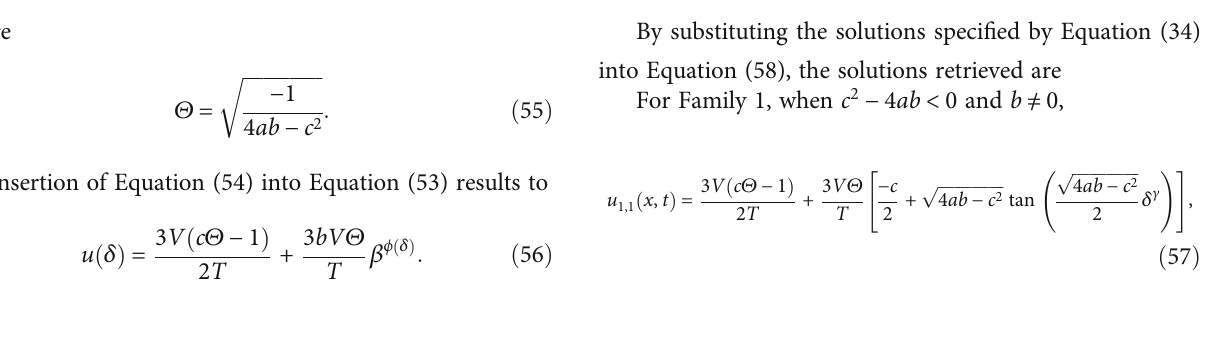
= 1 , T = 2 , V = 1 , c = 3 , a = 1 , b = 1 , and γ = 0 : 5,0 : 7,0 : 9 for the solution j u 1 ð x , t Þ with distinct values of γ 3,2